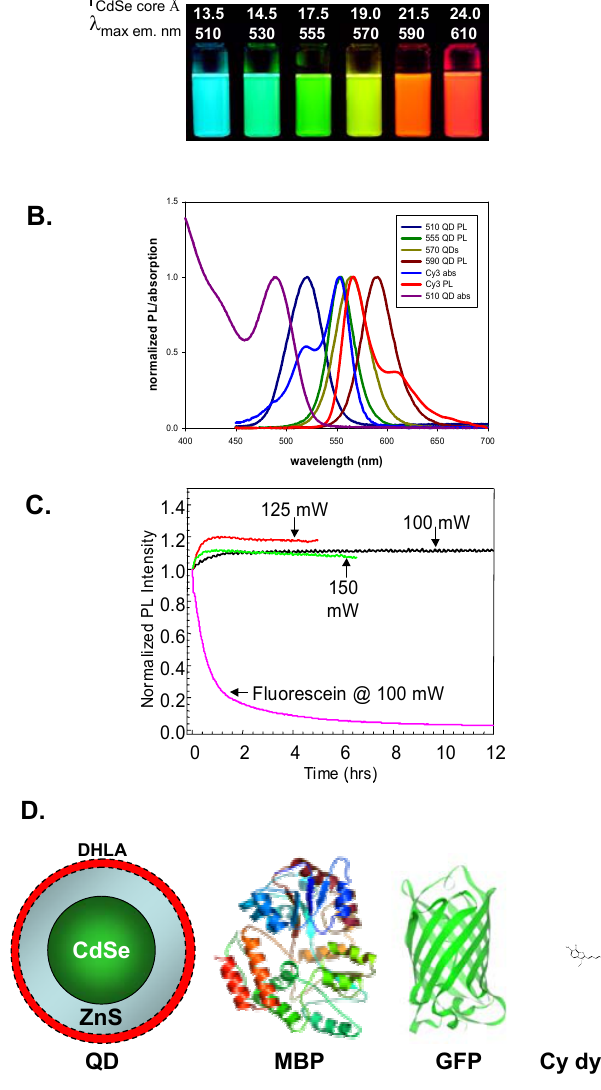
Figure 1. Quantum Dot Properties. A. Color photo demonstrating the size-tunable fluorescence properties and spectral range of 6 CdSe/ZnS core/shell QD dispersions. All samples were excited at 365 nm with a UV source. For the 610 nm emitting QDs, this translates into an effective Stokes shift of ~250 nm. Figure reprinted with permission of the Nature Publishing Group from ref [20]. B. Absorption of 510 nm QDs and emission of 510 nm, 555 nm, 570 nm, 590 nm QDs superimposed over the absorbance and emission spectra of Cy3 dye. emission of a solution of QDs at the indicated laser powers as compared to a reference fluorescein dye standard demonstrating QD